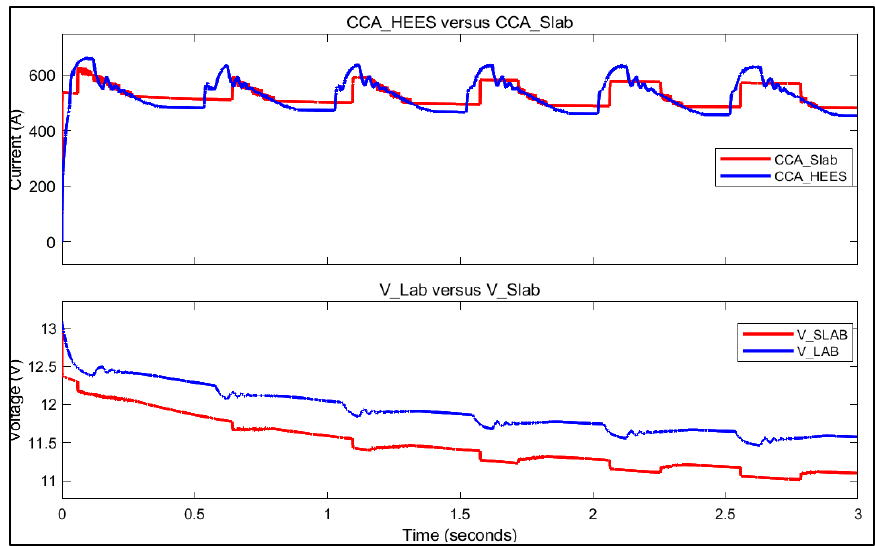
Figure 22. The delivered CCC by HESS versus SLAB, and voltage response of LAB versus SLAB during discharging mode for case three.